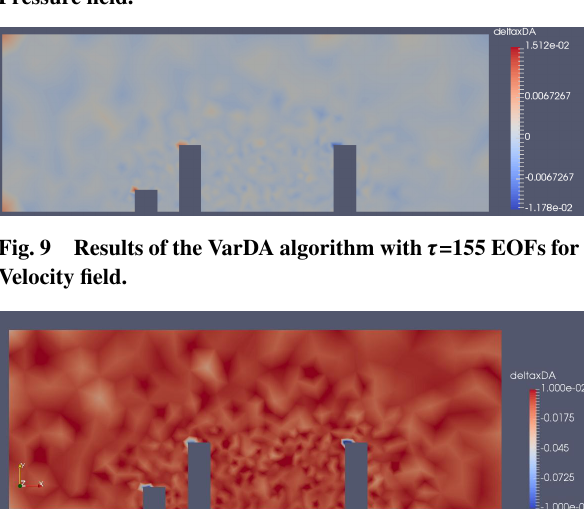
Fig. 8 Results of the VarDA algorithm with (cid:28)(cid:28)(cid:28) =155 EOFs for Pressure field.